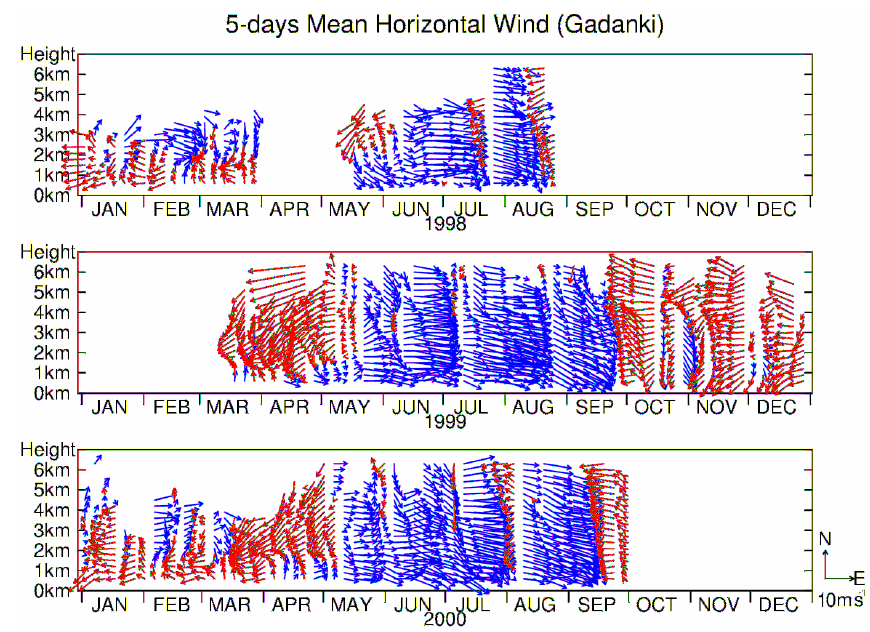
Fig. 2. Five-day mean horizontal winds observed for (top) 1998, (middle) 1999, and (bottom)